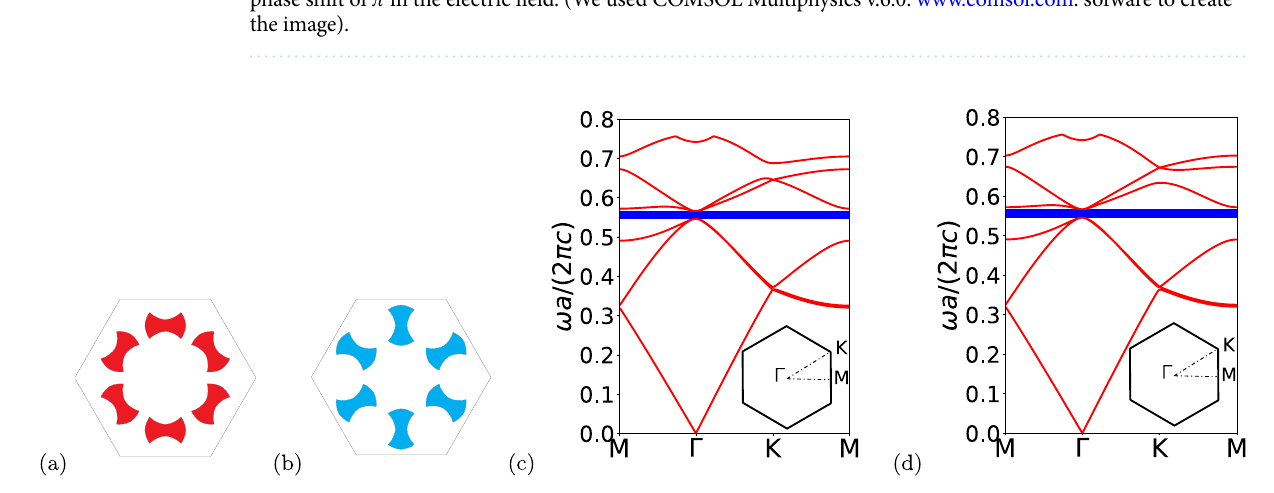
π/ 4 and ( b ) = − a / 3 , r R / 2 , for 11.7 , a 0.13 a and d 1 µ m , R = = = = = π/ 4 ). The bandgap is highlighted by the =